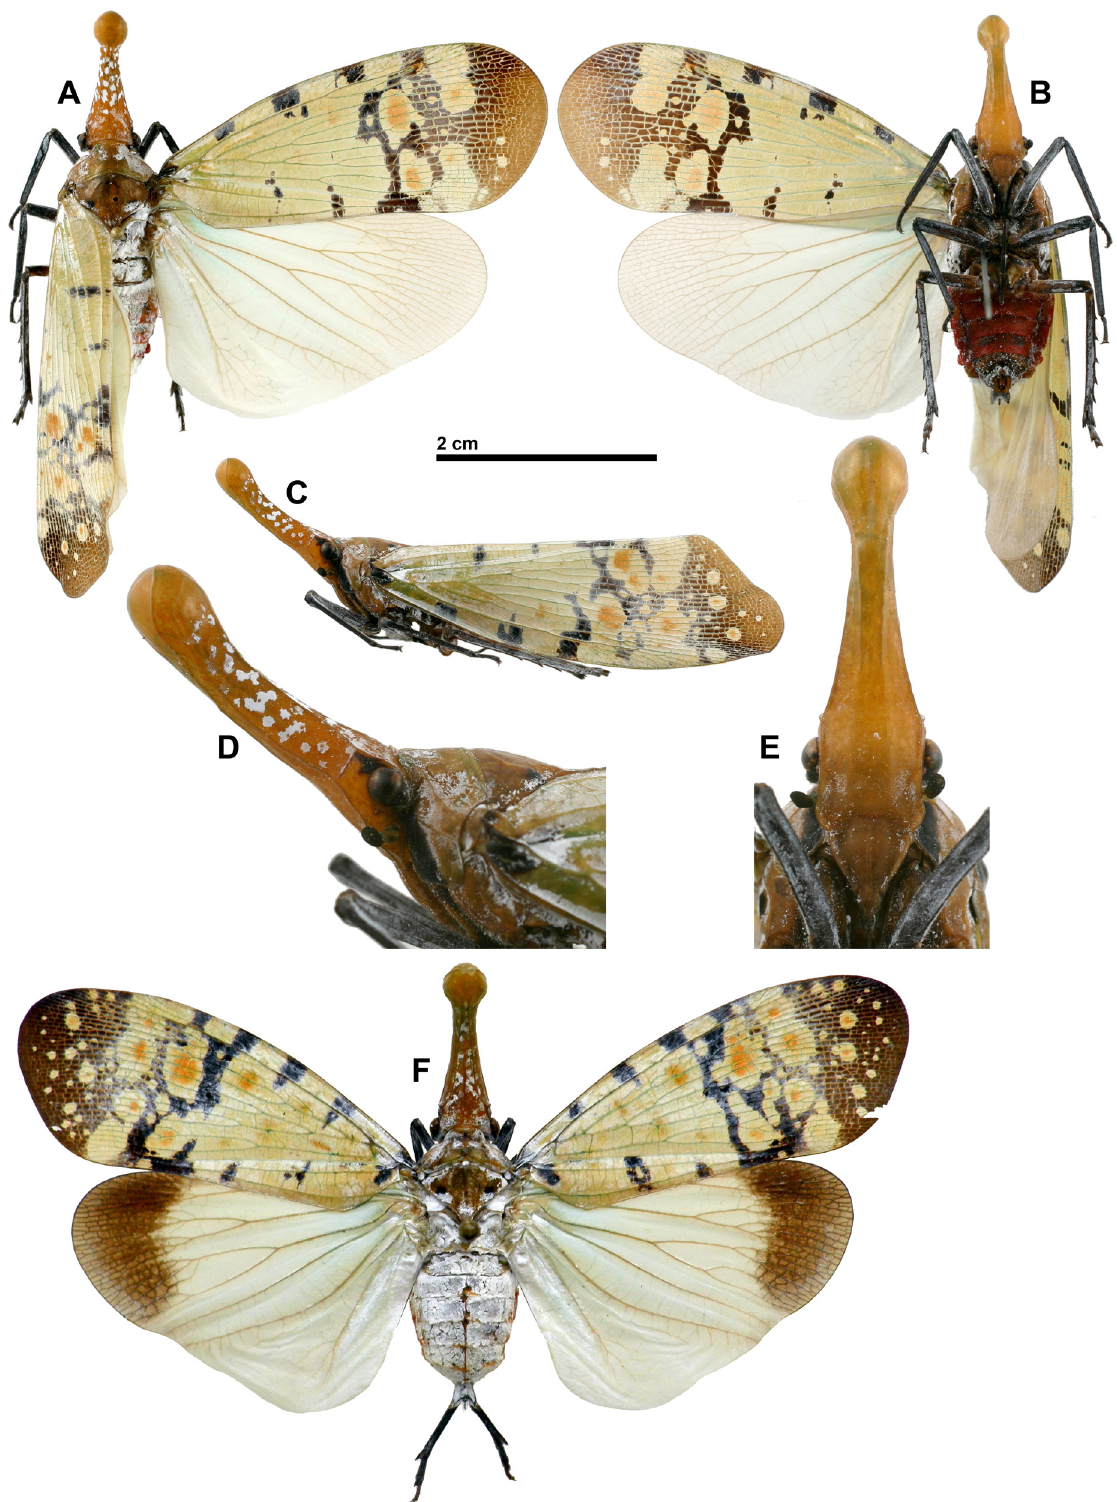
Fig. 4. Pyrops watanabei (Matsumura, 1913), ♀♀. A–E . Pale specimen, Taiwan, Taipei, Tanshui, 14 Jun. 2002 (NMNS). A . Habitus, dorsal view. B . Habitus, ventral view. C . Habitus, left lateral view. D . Head and thorax, left lateral view. E . Head, normal view of frons. — F . Dark specimen, Taiwan, Tao Yuan, 10 Jul. 2007 (MHNL, photograph by C. Audibert), habitus, dorsal view. (D–E not to